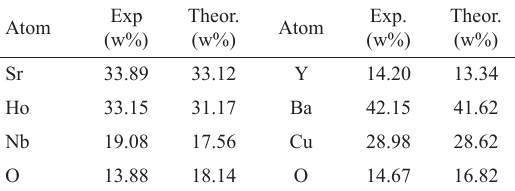
Figure 7: Energy dispersive X-ray spectra for (a) blank regions of the SEM images, which correspond to the SHNO double perovskite, and (b) darkness regions of the SEM images, which correspond to the YBCO compound. Table 2: EDX experimental and expected weight percentages for each atom in (left) SHNO double perovskite, and in (right) the YBCO material, by considering 7 oxygen atoms in the unit